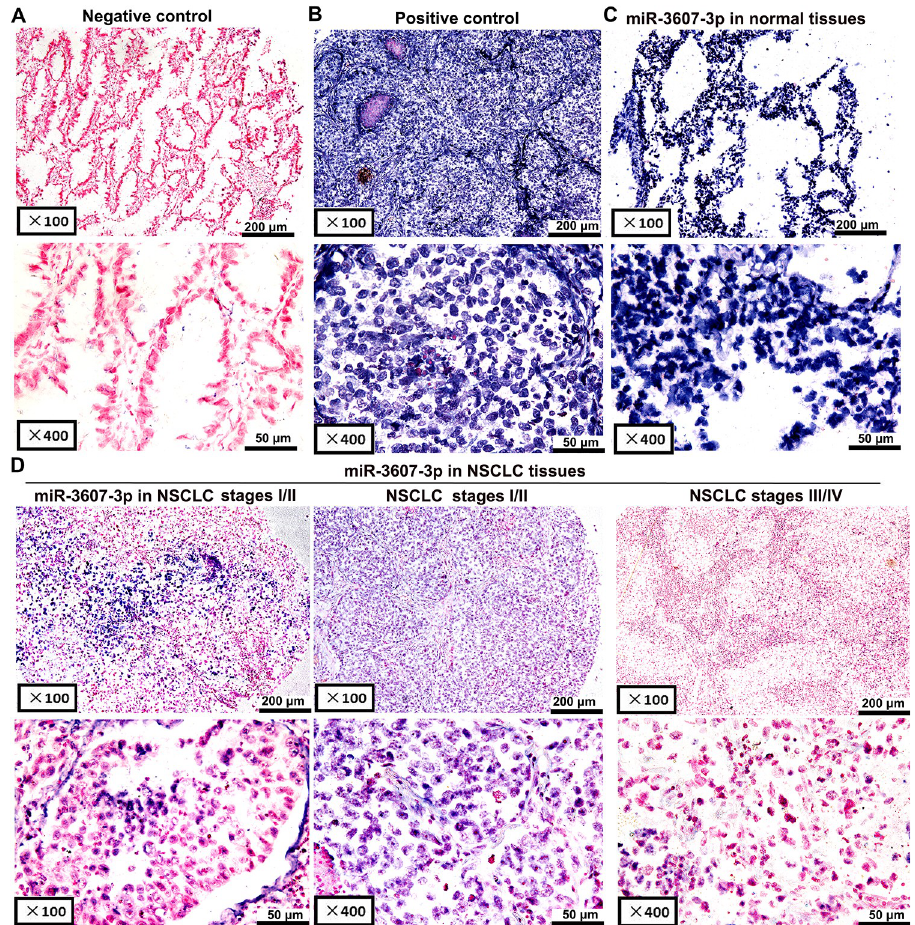
Fig 1. In situ hybridization to detect miR-3607-3p expression in 162 paired NSCLC and adjacent non-cancerous tissue samples. A negative or positive cytoplasmic signal for miR-3607-3p was observed in lung tissues. (A) Scrambled